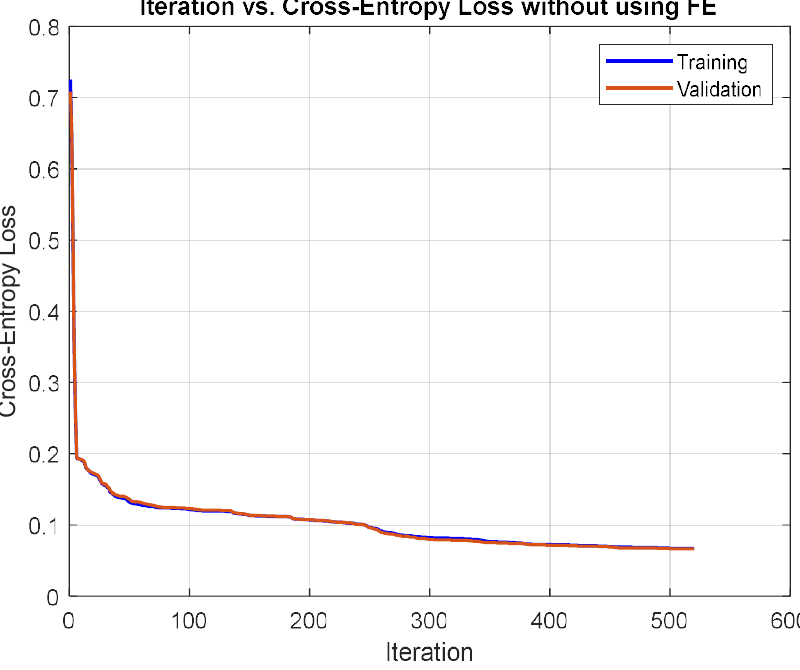
Figure 2. Iteration vs. cross-entropy loss for features extraction of noisy signals with length 6400, one hidden layer with ten nodes for DNN. Figure 3. Iteration vs. cross-entropy loss for noisy signals with length 1600, and one hidden layer with ten nodes for DNN.